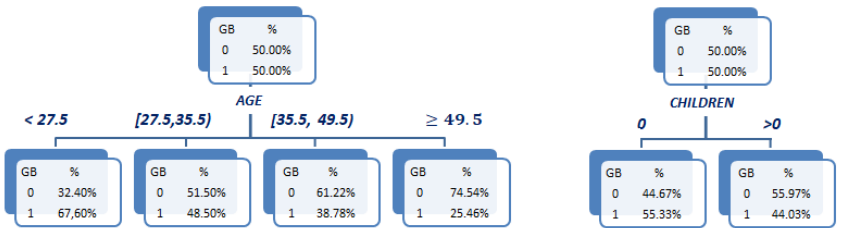
Figure 4. CART trees adjusted to variables AGE and CHILDREN in the CS _ ACCEPTS dataset (depth =